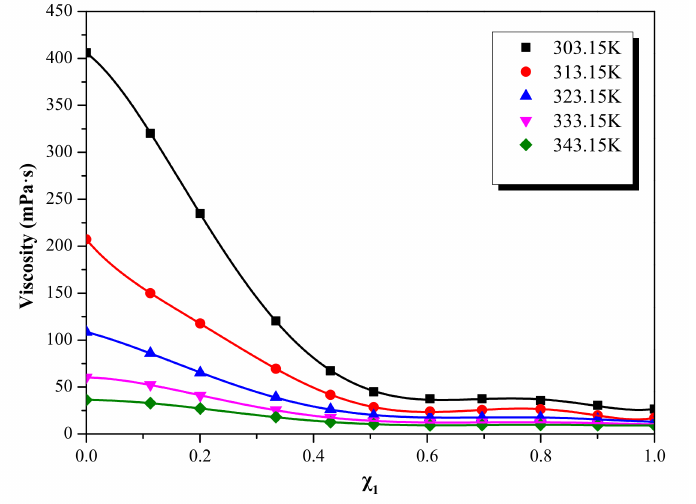
Figure 2. Viscosity η for the ([EMIM] [TFA] + TEA) systems, as a function of mole fraction of ILs, at different